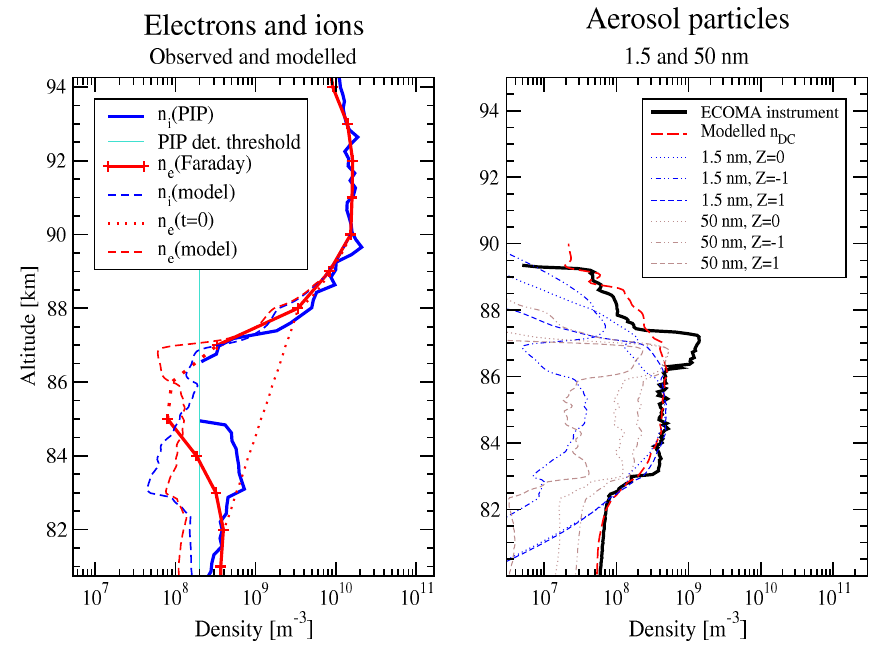
Fig. 8. Model with α = α m and two aerosol particle populations, one with r a = 50nm and the same density as measured by the ECOMA instrument (assuming singly negatively charged particles), and a smoke population with r a = 1 . 5nm and the same density as in Fig. 6. I a = 0 . 1 and 0 . 01s − 1 for the 50 and 1.5nm particles, respectively.